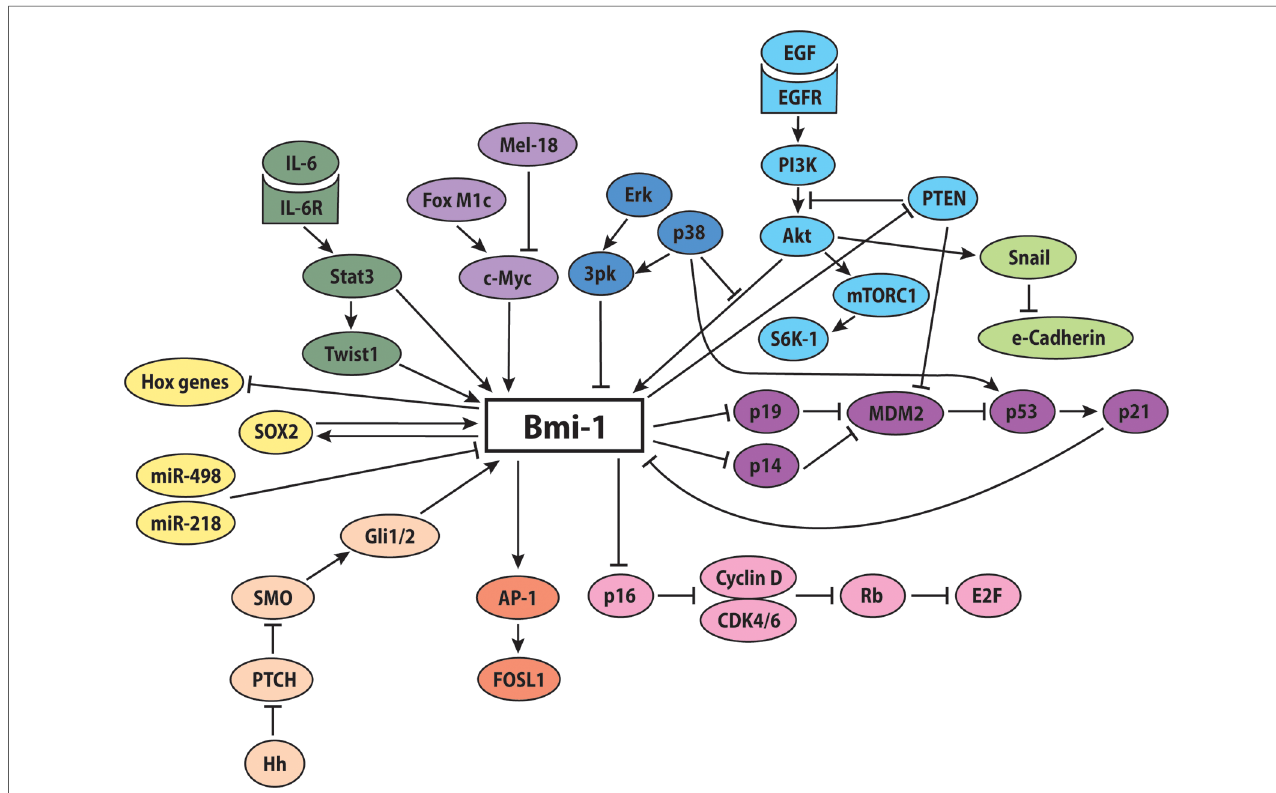
FIGURE 2 Potential involvement of Bmi-1 in key signaling pathways. The proposed molecular signaling network of Bmi-1 promotes increased stemness, self-renewal, and proliferation, while decreasing apoptosis, differentiation, and